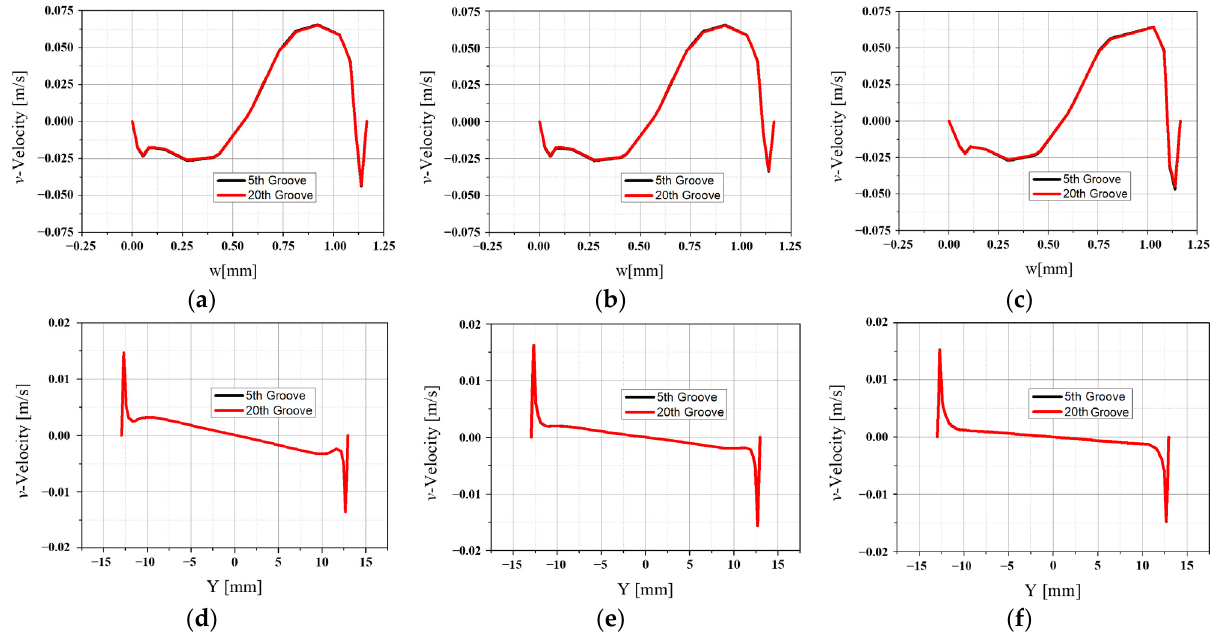
Figure 15. The v -velocity distribution at the interface of the groove and main flow at the 5th and 20th case and the v -velocity